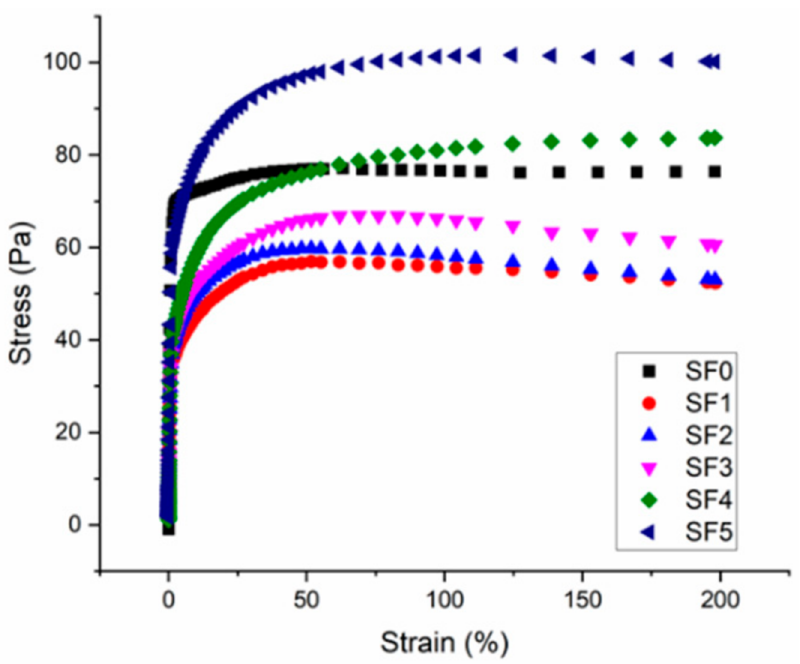
Figure 7. Shear stress versus strain at a constant shear rate of 0.0067 s − 1 for CBR gel formulations with 0–5 wt.%